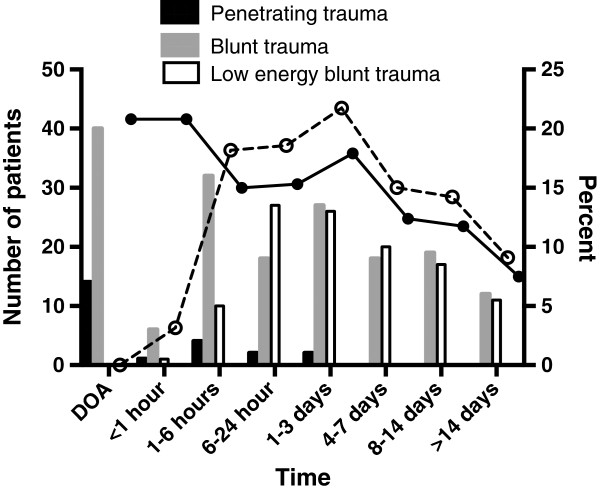
Number of deaths from penetrating (n = 23), blunt (n = 172) and low energy blunt trauma (n = 112) and percentage of all deaths (• symbol and solid line) and all deaths excluding patients DOA (ο symbol and dotted line) versus time intervals.